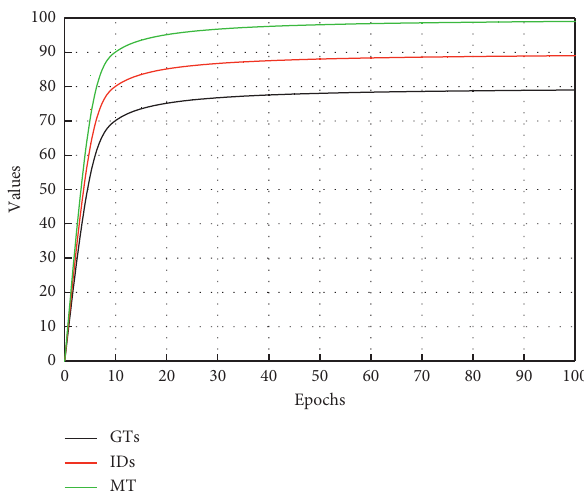
Figure 6: Tracking system performance comparison